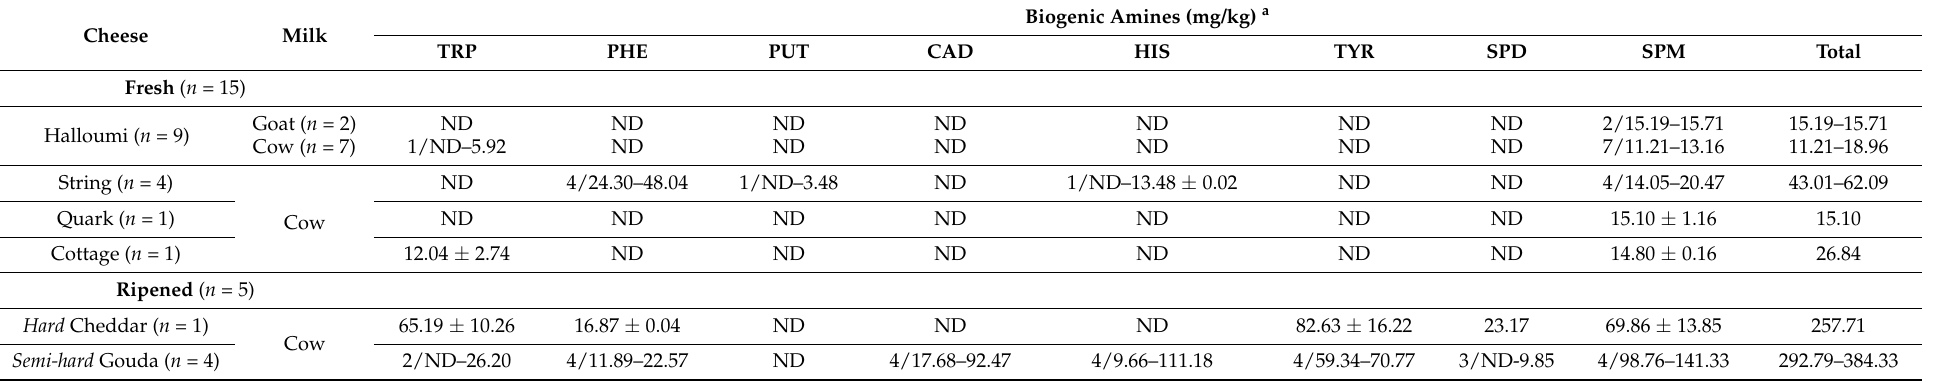
Table 3. Total and individual biogenic amine contents in cheese samples from the farmsteads in the Republic of